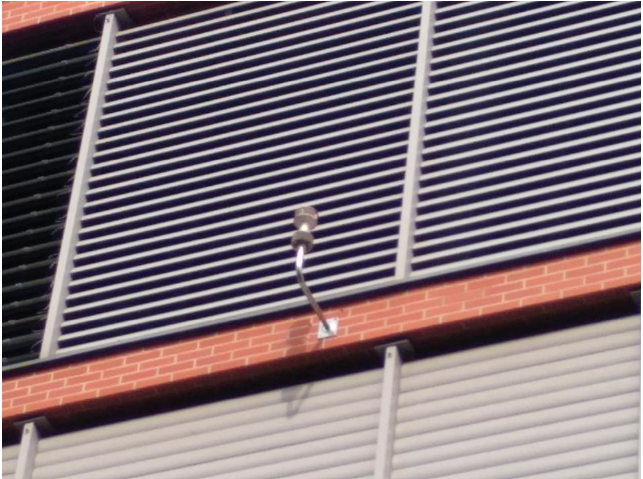
Figure 5. Weather station on the southern façade.